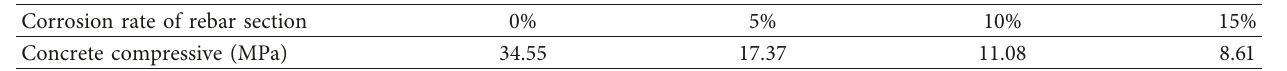
Table 5: The strength of the concrete cover of the corroded member.